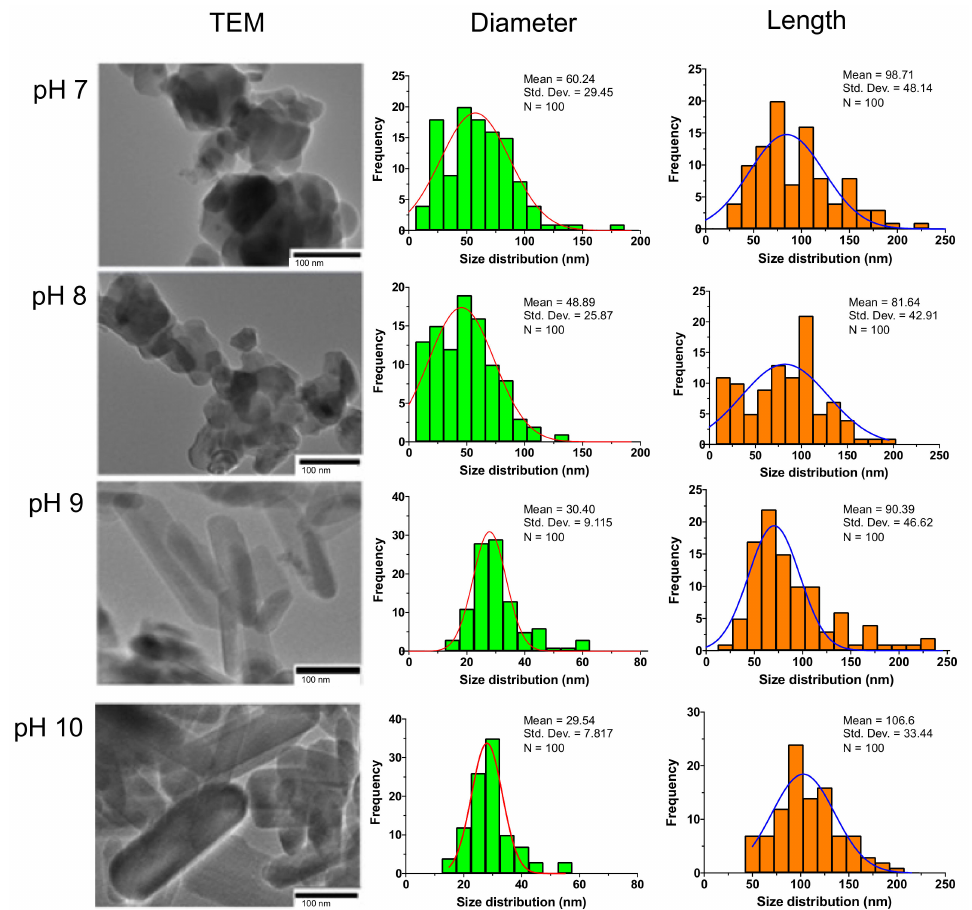
Figure 2. TEM micrographs of the HAp synthesized at different pH values and their corresponding diameter and length histograms (TEM scale bar: 100 nm). Depending on the initial reaction pH environment, different morphologies can be observed: standing out are the presence of semi-spherical particles for lower pH and rod-like shapes particles for higher